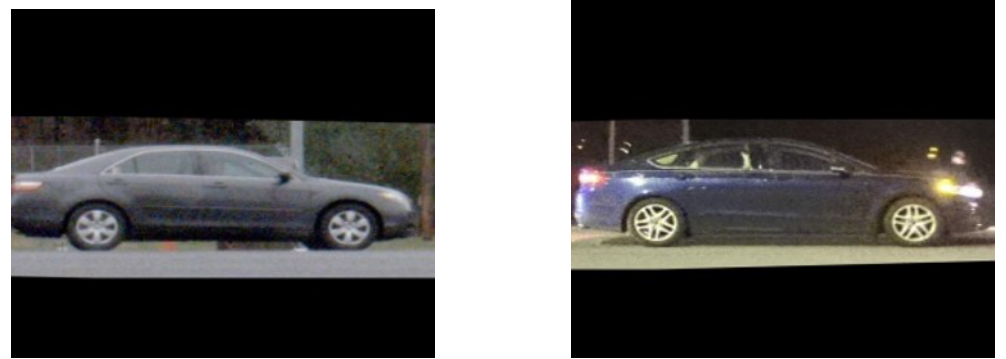
Figure 14. Vehicle similarity score = 0.958; wheel similarity scores = 0.01, 0.001.